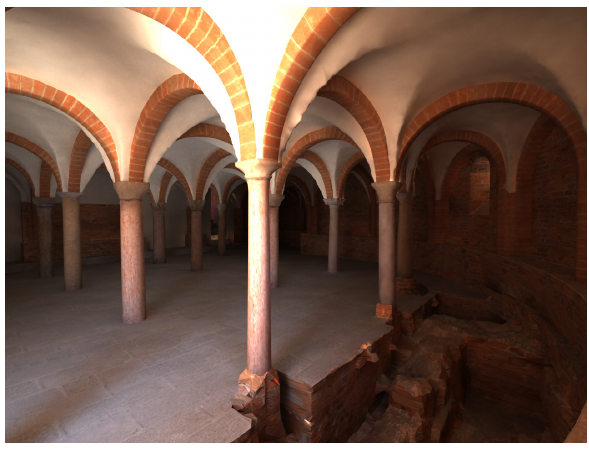
Figure 4. Texturized polygonal model of the real crypt.